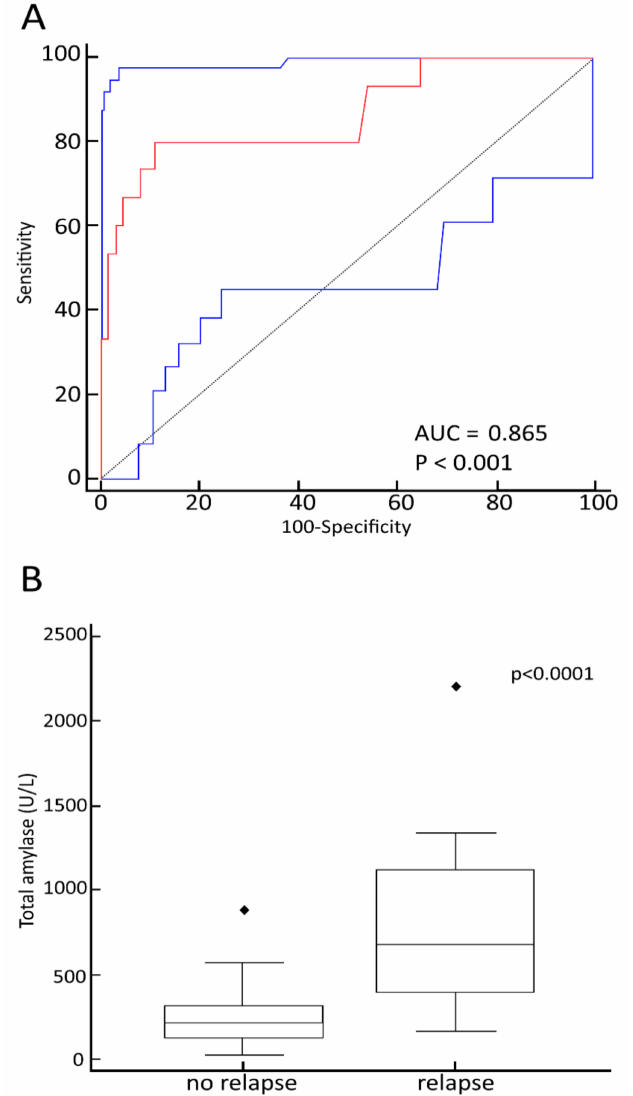
Figure 4. ( A ) Receiver operative characteristics curves of total amylase diagnostic performance in predicting leukemia relapse-related death after hematopoietic stem cell transplantation with total body irradiation-based conditioning. ( B ) Box-and-whisker plot of maximum total amylase values of recurrence-free patients and patients with disease